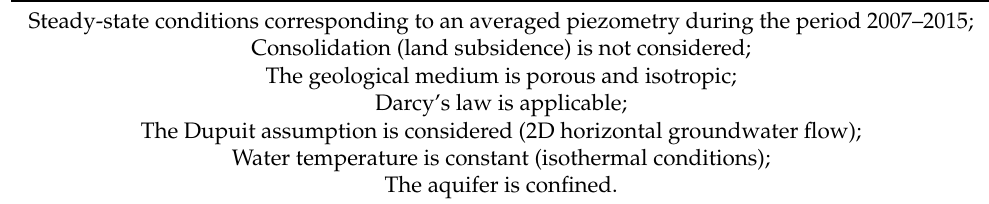
Table 3. Conditions and assumptions adopted for the development of the conceptual model. Steady-state conditions corresponding to an averaged piezometry during the period 2007–2015; Consolidation (land subsidence) is not considered; The geological medium is porous and isotropic; Darcy’s law is applicable; The Dupuit assumption is considered (2D horizontal groundwater